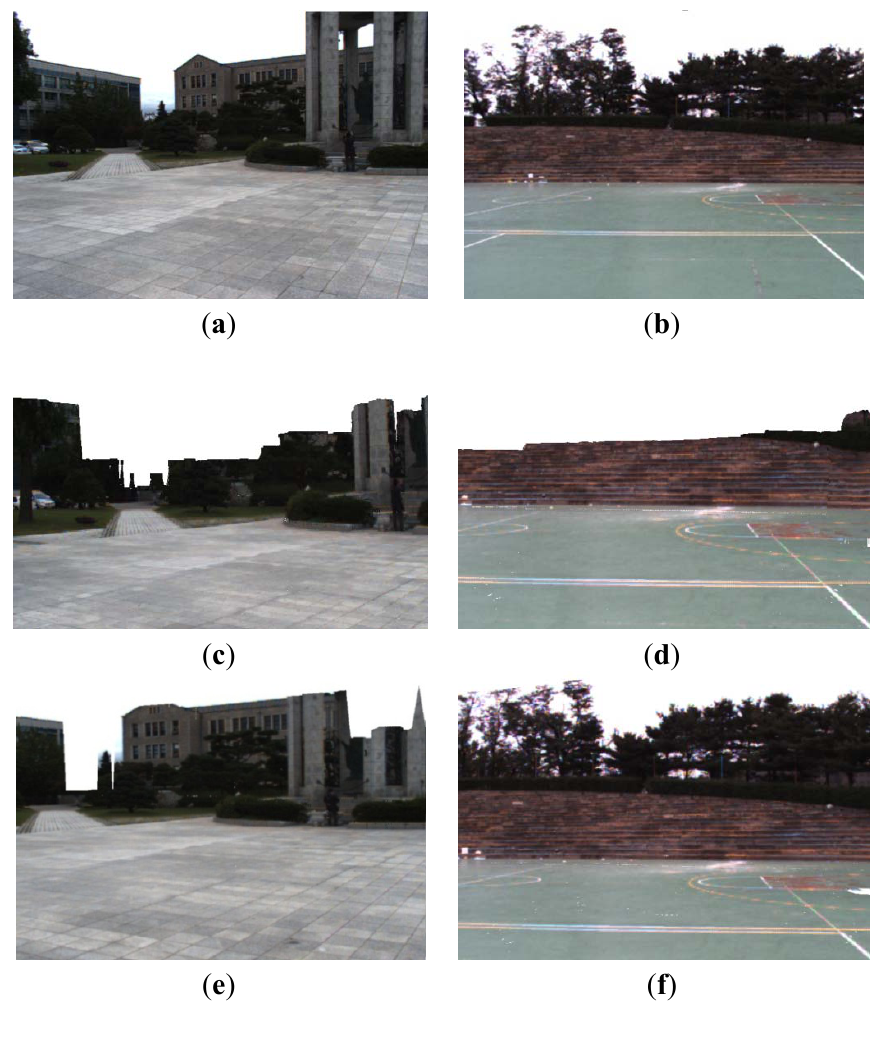
Figure 15. Other simulation results using the proposed terrain reconstruction methods. ( a , b ) Captured 2D images. ( c , d ) Textured terrain meshes generated from sensed point clouds directly. ( e , f ) Terrain reconstruction using the proposed 3D boundary detection from (c) and (d)